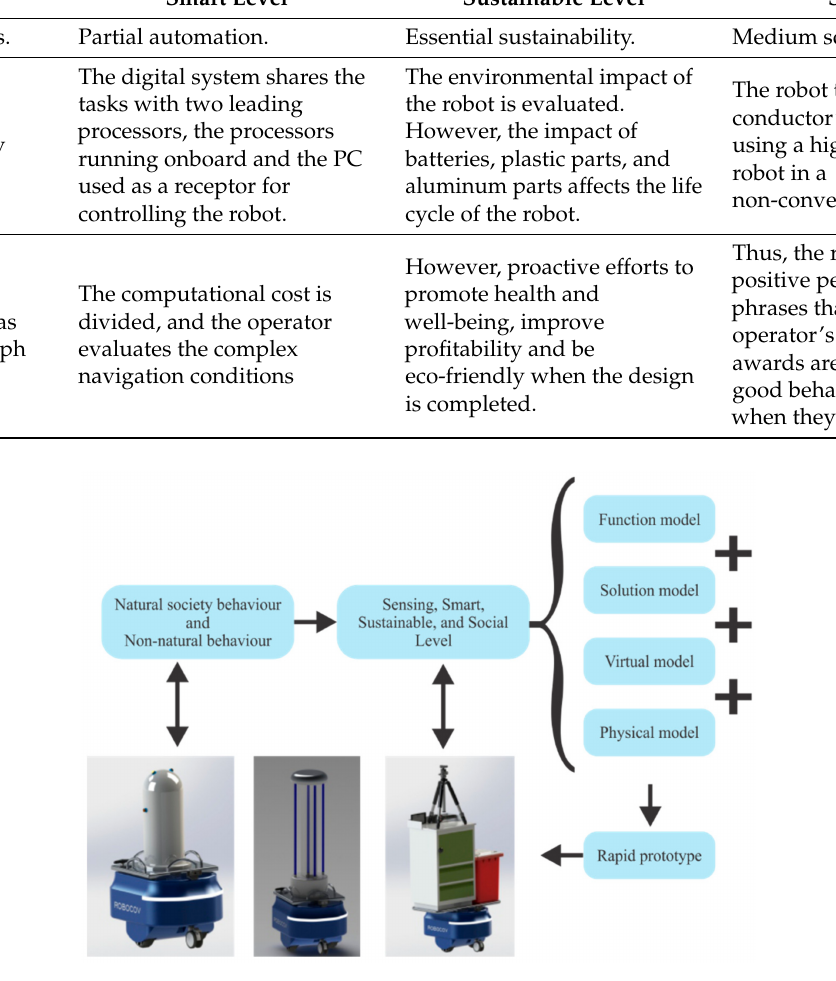
Figure 3. Flow chart to design a rapid prototype of a reconfigurable